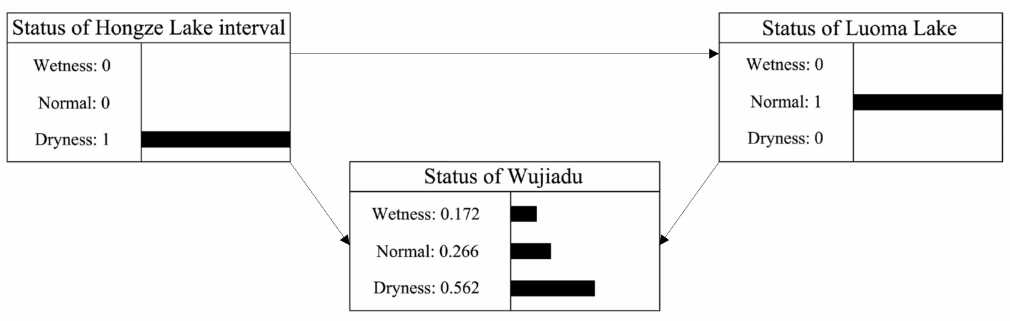
Figure 12. The Bayesian network diagram when the statuses of Hongze Lake interval and Luoma Lake are dryness and normal (in